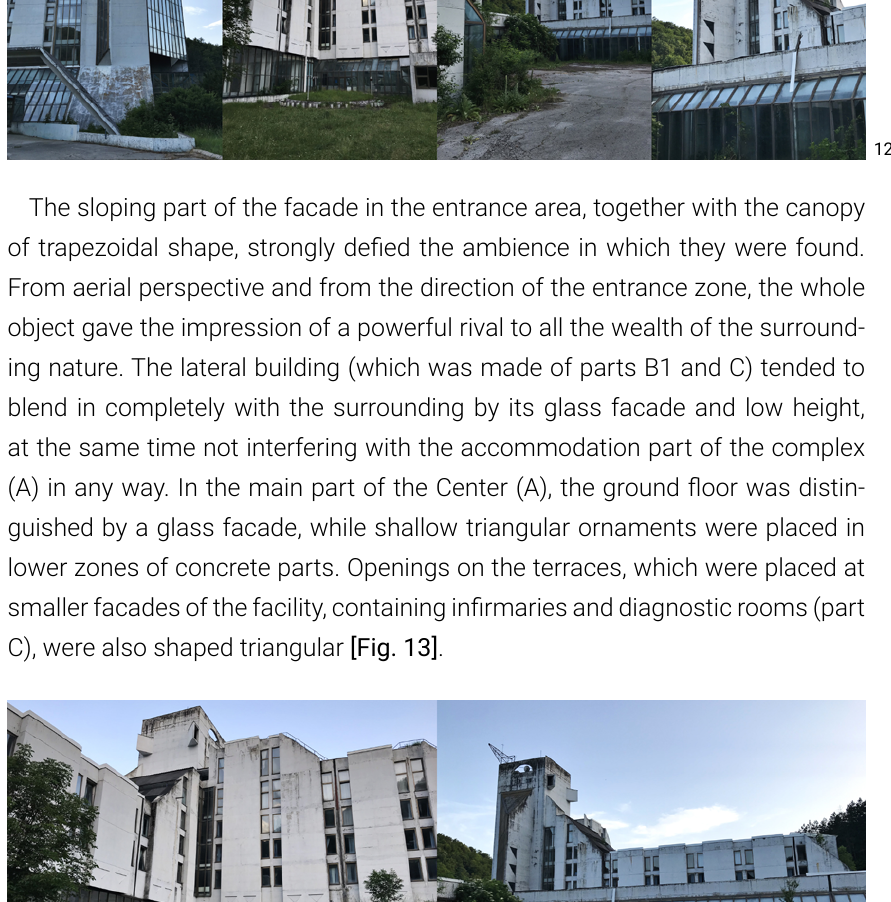
Franc Avbelj et al., Medical and Recreational Center Žubor in Kuršumlija Spa (1976-1982), Back and Side Facade (Cop- yright Aleksandra Jevtović,